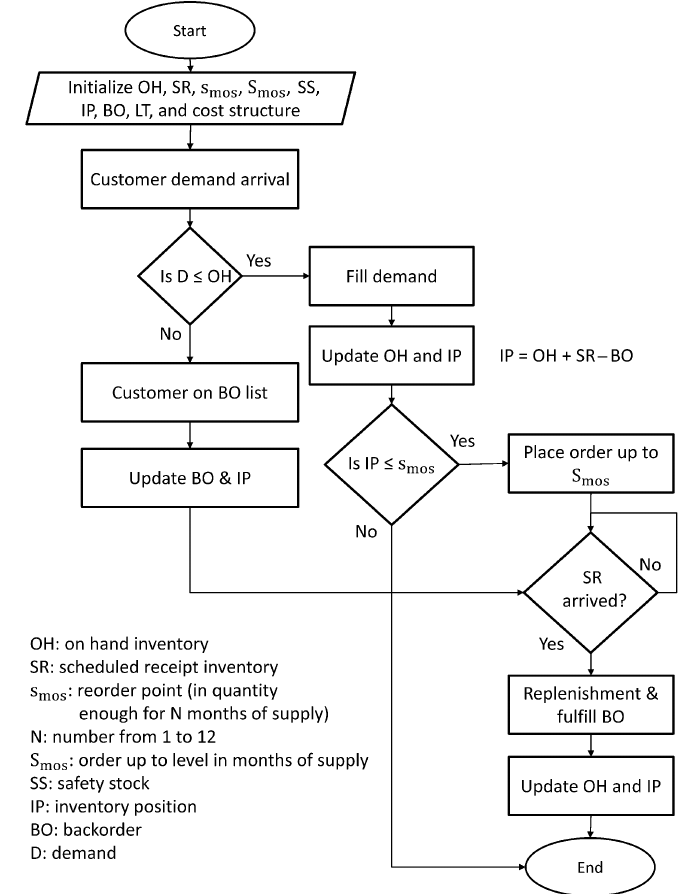
Fig. 4. Conceptual model for (s, S) inventory control